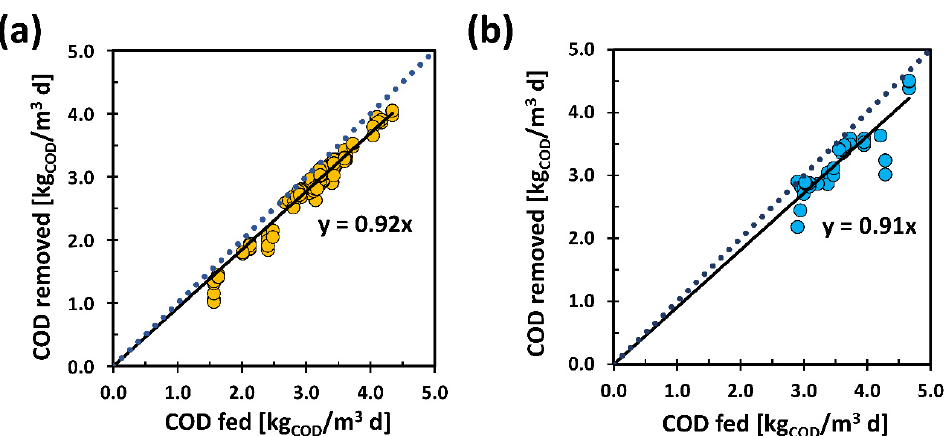
Figure 2. COD removal yields with TBSS ( a ) and DBSS ( b ). The continuous black lines represent the fitting of COD removed as a function of COD fed while the dot blue lines represent the condition of complete COD removal.